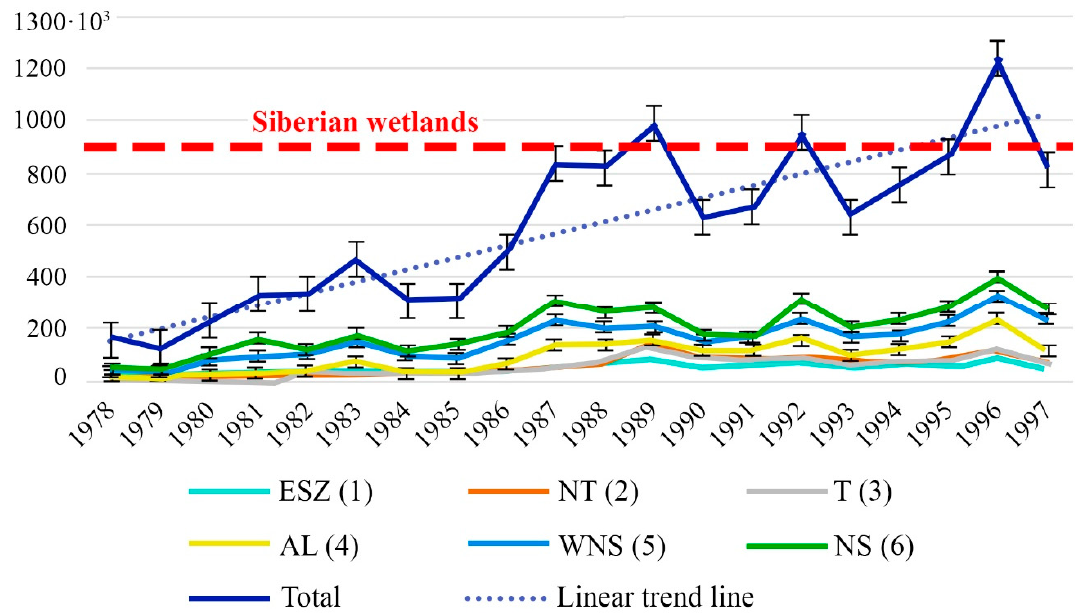
Figure 7. Increase in the areas of flaw polynyas (km 2 ) composing the Great Siberian Polynya observed over two decades: ESZ—Eastern Severnaya Zemlya polynya, NT—Northeastern Taimyr polynya, T—Taimyr polynya, AL—Anabar Lena polynya, WNS—Western New Siberian polynya, NS—New Siberian polynya, after [83]. An area of the Siberian wetlands is shown as a red dotted line